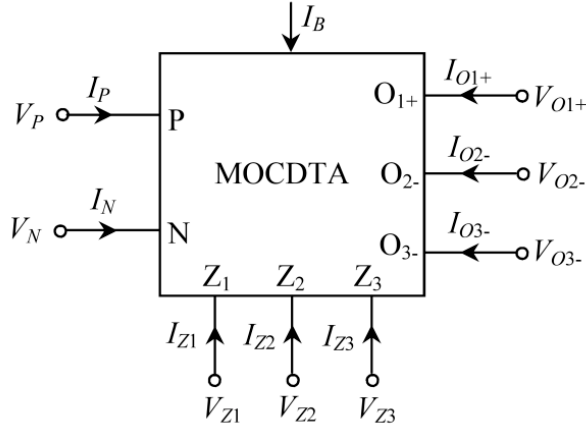
Figure 1. Symbol of MOCDTA.